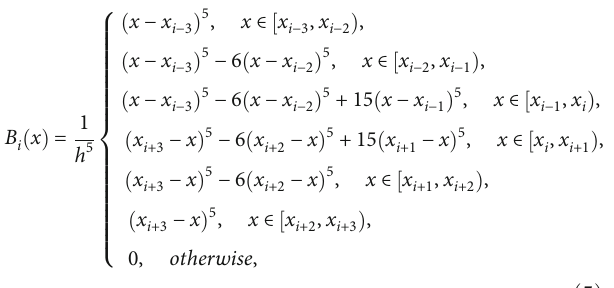
ð x Þ and the fi rst i